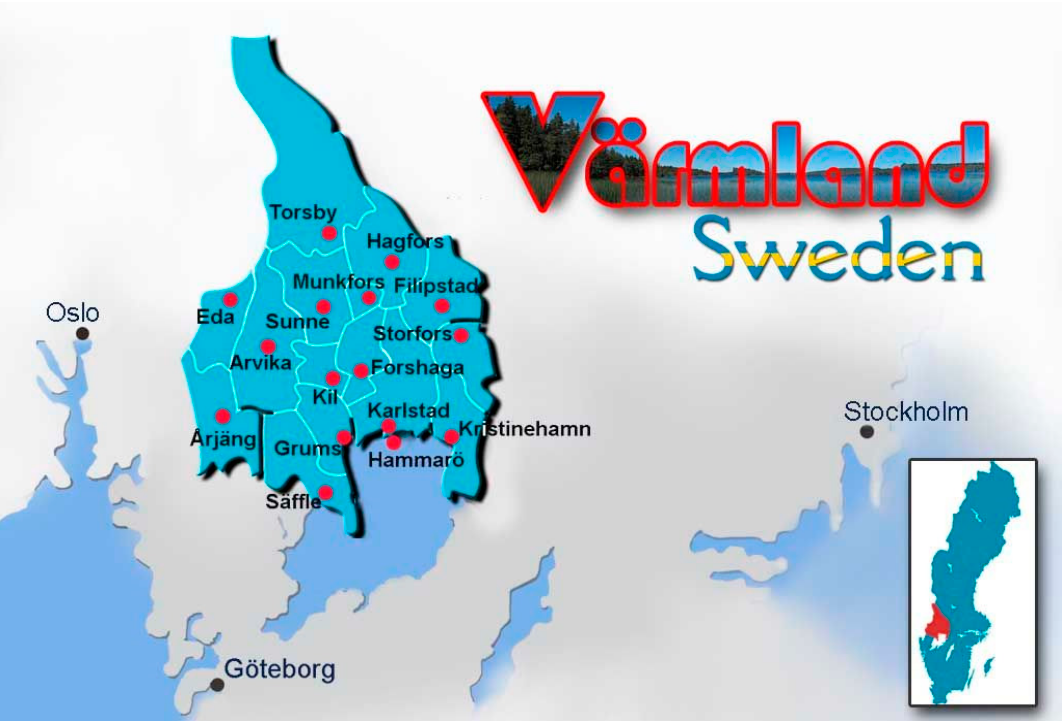
Figure 2. Värmland Region and town of Grums [13].